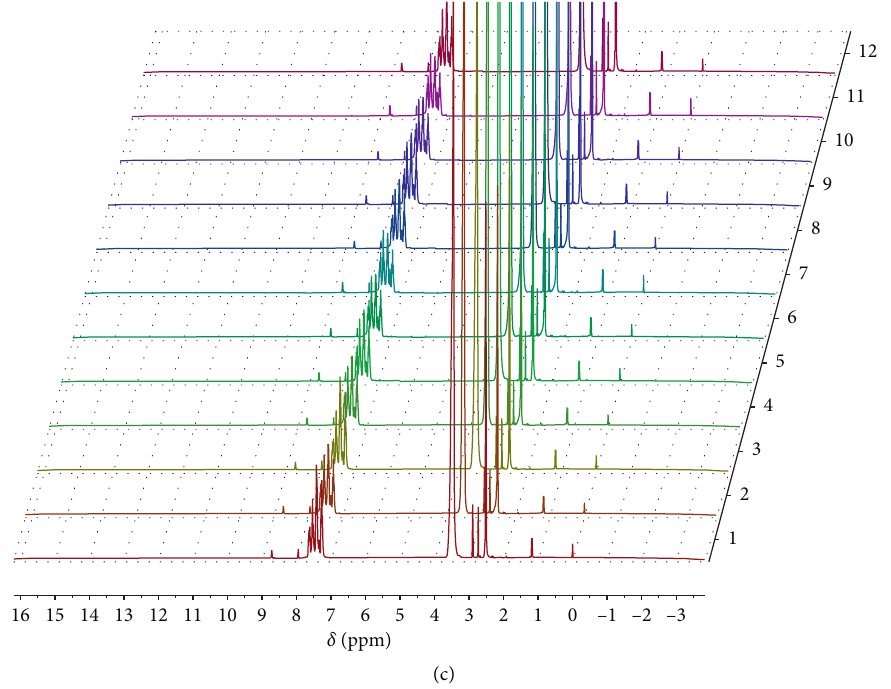
Figure 8: I H-NMR scans for (a) C1 , (b) C2 , and (c) C4 at 6h intervals for 72 h in the presence of D